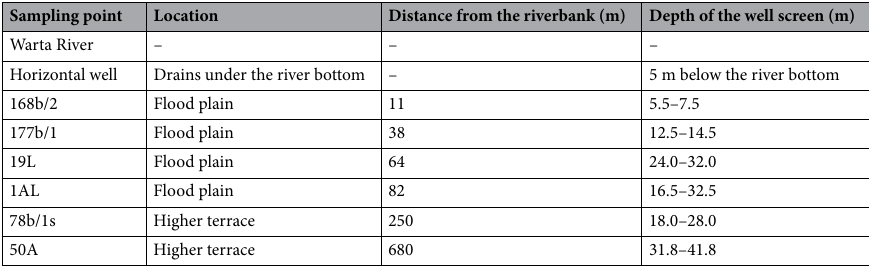
Table 1. Sampling points characterisation.